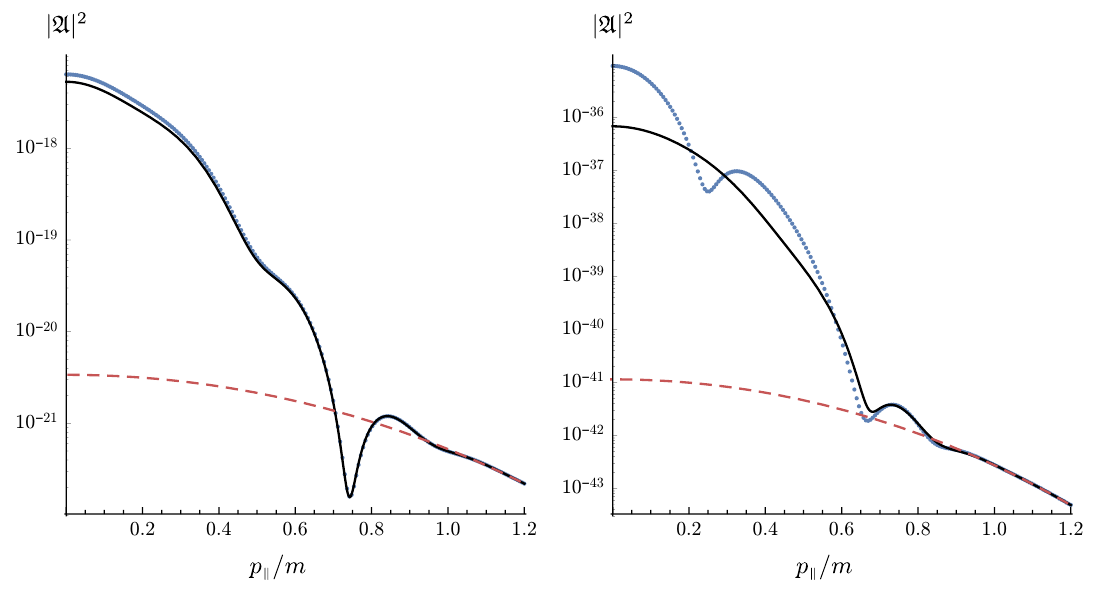
Figure 3 . Logarithmic plots of the pair production probability as a function of the longitudinal momentum p =m , with p = 0. The strong (cid:12)eld is a Sauter pulse and the weak (cid:12)eld is a Gaussian k ? pulse (2.16). The parameters are E = 0 : 066 E crit and (cid:13) = 3 : 9 for the left plot, E = 0 : 033 E crit and (cid:13) = 3 : 8 for the right plot, and (cid:13) slow = 0 : 2 and " = 10 (cid:0) 3 in both cases. The curves are obtained as described in (cid:12)gure 1, where A 0 (cid:25) (cid:0) (cid:12) (cid:3) is obtained from (4.20) and A 1 from (4.31). In the left plot we (cid:12)nd a rather good agreement with the (cid:12)rst order results. However, in the right plot there clearly are important contributions that are not captured by the (cid:12)rst